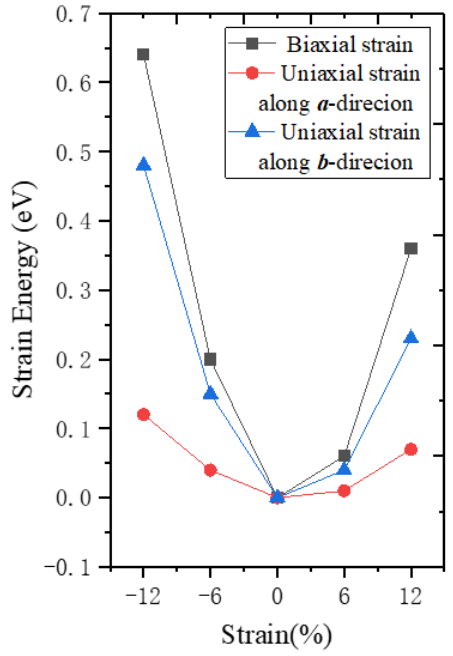
Figure 6. The strain energy under different strains.